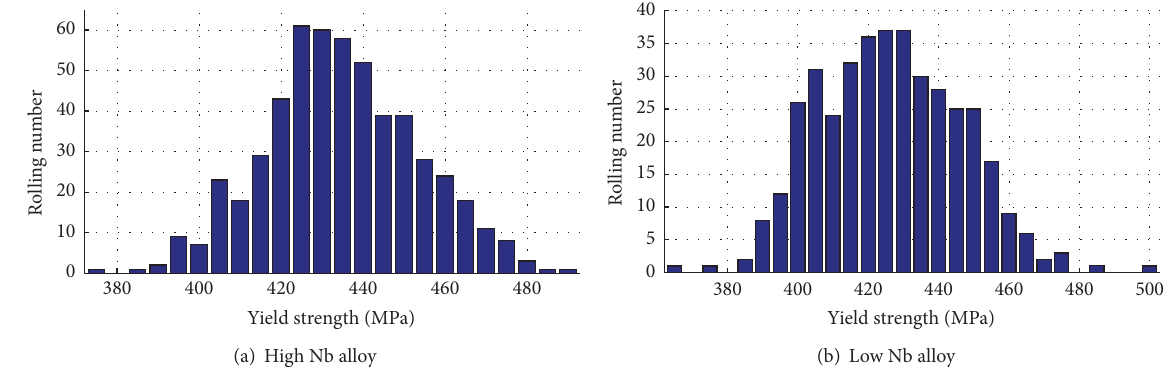
Figure 8: Statistical histogram of yield strength of steel plate before and after